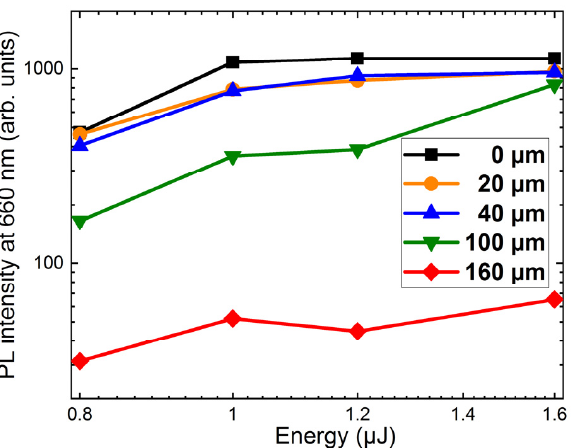
Figure 4. Peak intensity of NV band at 660 nm at different depths versus incident 0.3 ps laser pulse energy.